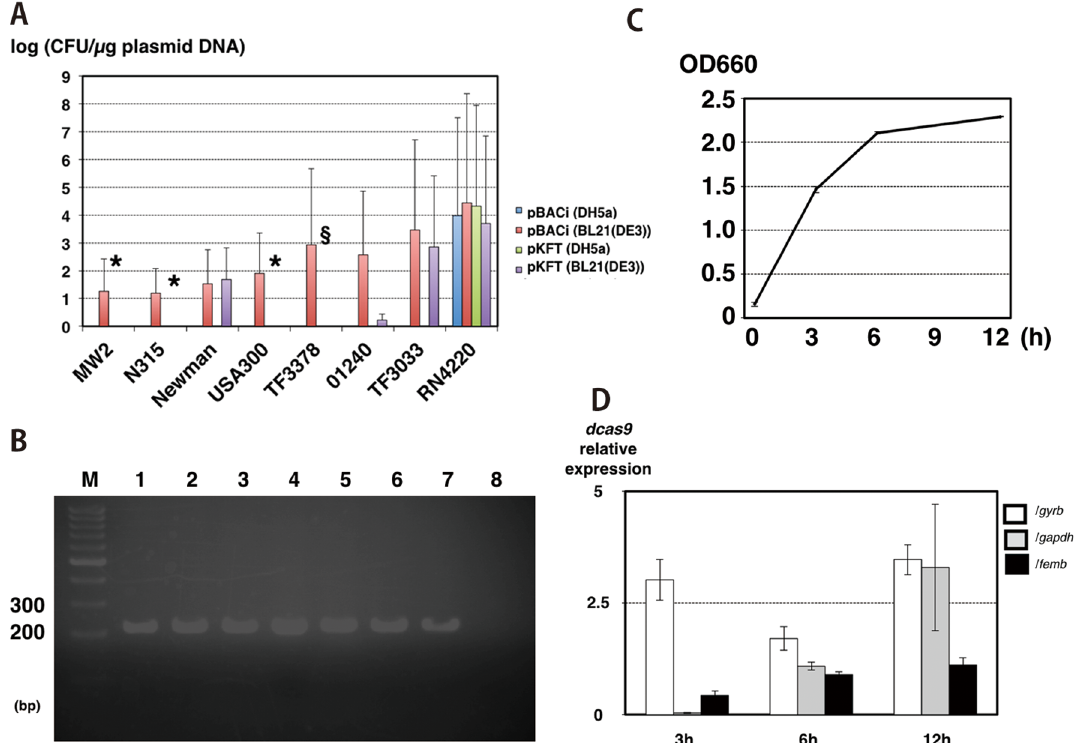
Fig 2. Evaluation of the novel CRISPRi plasmid for S . aureus . 2A. Transformation efficiencies of S . aureus . The transformation efficiencies of pBACi and pKFT are shown. Both plasmids were extracted from DH5 α ( dcm +)and BL21(DE3) ( dcm -).Electroporation of all strains was performed at least three times. When no transformants were obtained until three trials, seven more electroporations (total n = 10) were conducted. (cid:3) : Strains which could accept pKFT extracted from RN4220 (Transformation efficiency is 16.8~1118.2CFU/ µ g DNA). §: Strains which could not accept pKFT extracted from RN4220. 2B. Confirmation of correct transformation. The MW2 transformants were subjected to PCR. 1–3: Transformants using pBACi extracted from BL21(DE3). 4–6: Transformants using pBACi extracted from RN4220. 7: pBACi DNA. 8: No DNA (only purified water). M: 100bp marker. 2C. Growthcurve of MW2/pBACi. Temporal measurementof OD 660 are shown. Three independent cultures were performed. After inoculation of 1/100 volume o/n pre- culture media into fresh media (OD 660 : ~0.1), the temporal samplings (3 h: early-mid log phase, 6 h: late log phase, and 12 h: stationary phase) were performed. Vertical line: OD 660 . Horizontal line: time (hours, h). Average and standard error (SE) are shown. 2D. Relative expression of dcas9 .The temporal expression of dcas9 in MW2/pBACi is shown. Three genes were used as reference genes. Gyrase subunit B ( gyrB ):white, glyceraldehyde 3-phosphate dehydrogenase ( gapDH ):gray and femB :black. Three independent samples of three cultures and three qPCR assays were conducted (n = 9/sample). The samplings were performed at three time points as described above. Average and SE are